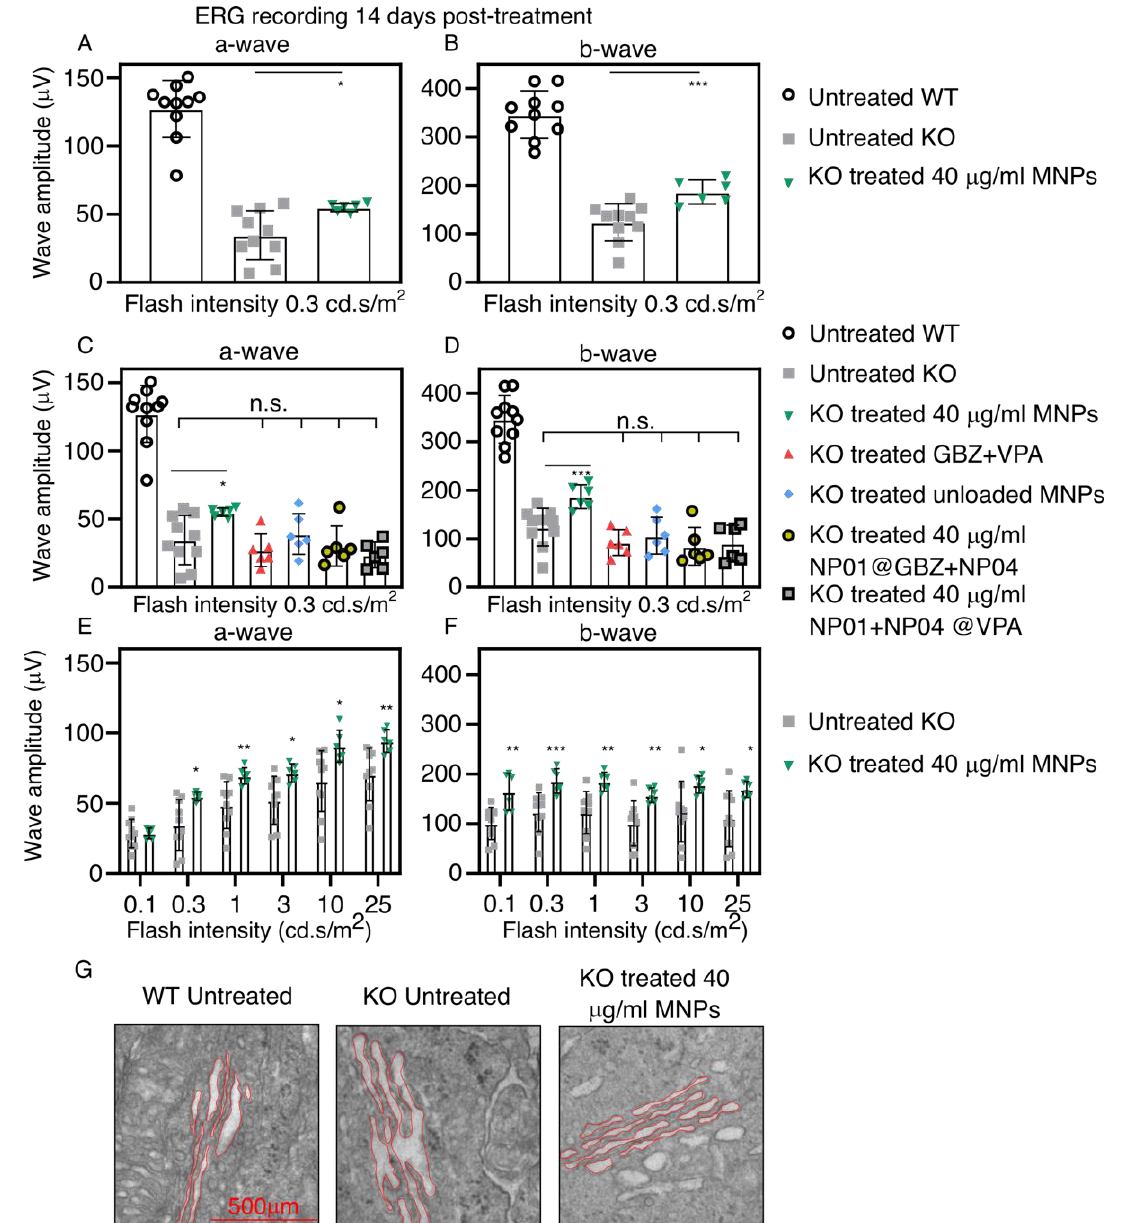
Figure 5. Effect of the MNP-based eye drops on the a-wave and b-wave amplitudes in the ERG measurements and on the ER dilatation . The graphics show ( A ) the average a-wave, and ( B ) the average b-wave of the untreated and treated (40 µg Fe/mL MNP with GBZ and VPA) mice at a light intensity of 0.3 cd.s/m 2 . The average a-wave ( C ) and b-wave ( D ) amplitudes recorded at a low flash intensity (0.3 cd.s/m 2 ) from the untreated WT mice (white circles, black outline) and untreated KO mice (gray square) compared to the control groups: KO mice treated with GBZ and VPA but without MNPs (red triangle), unloaded MNPs (blue rhombus), MNPs loaded with either GBZ (gray circle, black outline) or VPA (gray square, black outline). The average a-wave ( E ) and b-wave ( F ) amplitudes of KO untreated mice compared to KO mice treated with MNPs (Fe 40 µg/mL loaded with GBZ and VPA) recorded in a wide range of flash intensities (0.3–25 cd.s/m 2 ). ( G ) Representative TEM images showing the decrease in the ER dilatation (highlighted in red) of the mice treated with the 40 µg Fe/mL MNPs when compared to the untreated Bbs -/- mice. The mean ± SD from untreated WT mice ( n = 9), untreated KO mice ( n = 9), and all other groups ( n = 6) are shown. * p < 0.05, ** p < 0.01, *** p < 0.005.